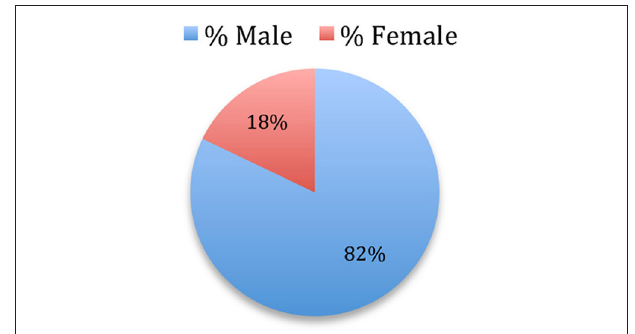
FIGURE 25 | Extrapolated authorships’ gender.